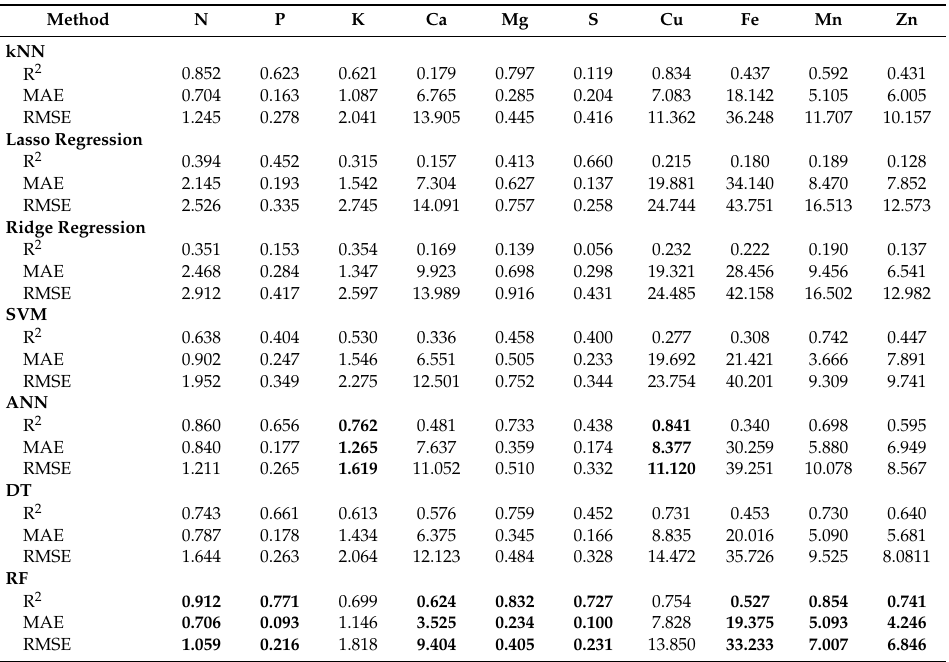
Table 4. The machine learning algorithms’ accuracy performance for the reflectance data.